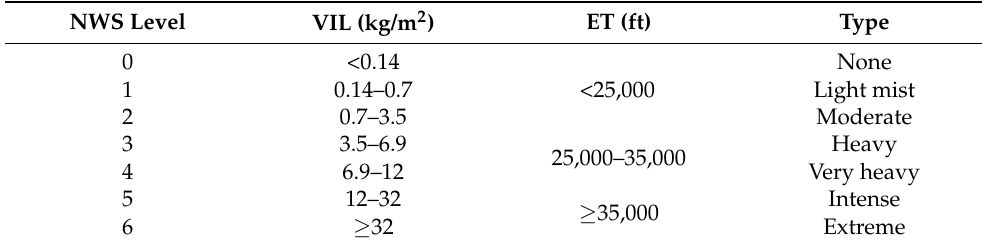
Table 1. NWS level and numerical range of weather